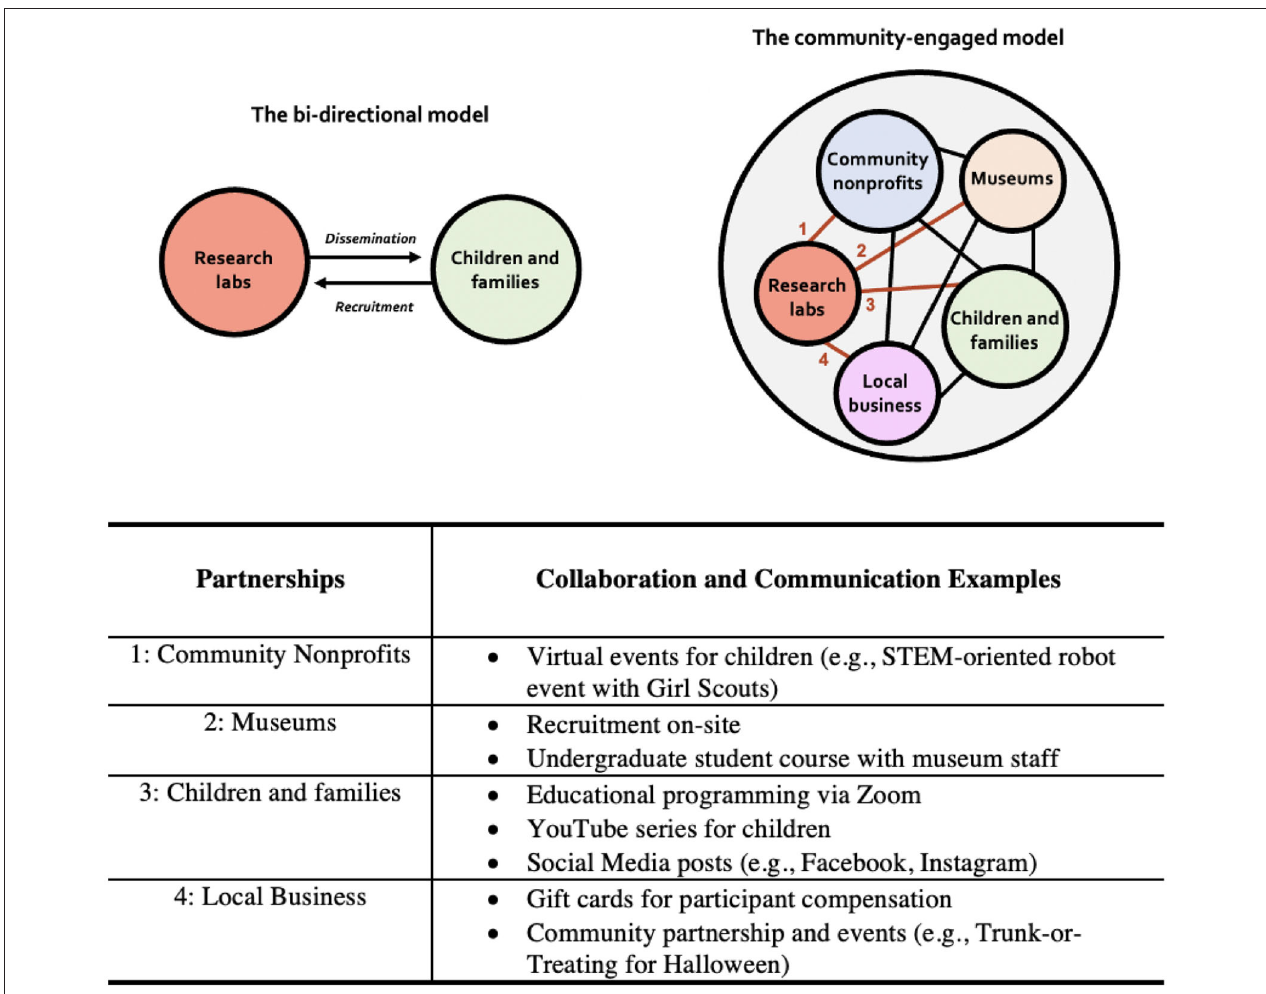
FIGURE 1 | The schematic depiction of the differences between the traditional model (left) and the community-engaged model (right) with a list of collaboration and communication examples (bottom). Under the traditional model, the typical relationship between developmental research labs and community stakeholders is a bi-directional exchange whereby communities provide data to scientists provide knowledge to communities. In the community-engaged model, research labs’ explicitly aticulate commitments to reinforce patnerships through resource and knowledge sharing based on reciprocity and mutual benefit (Kretzmann and McKnight,